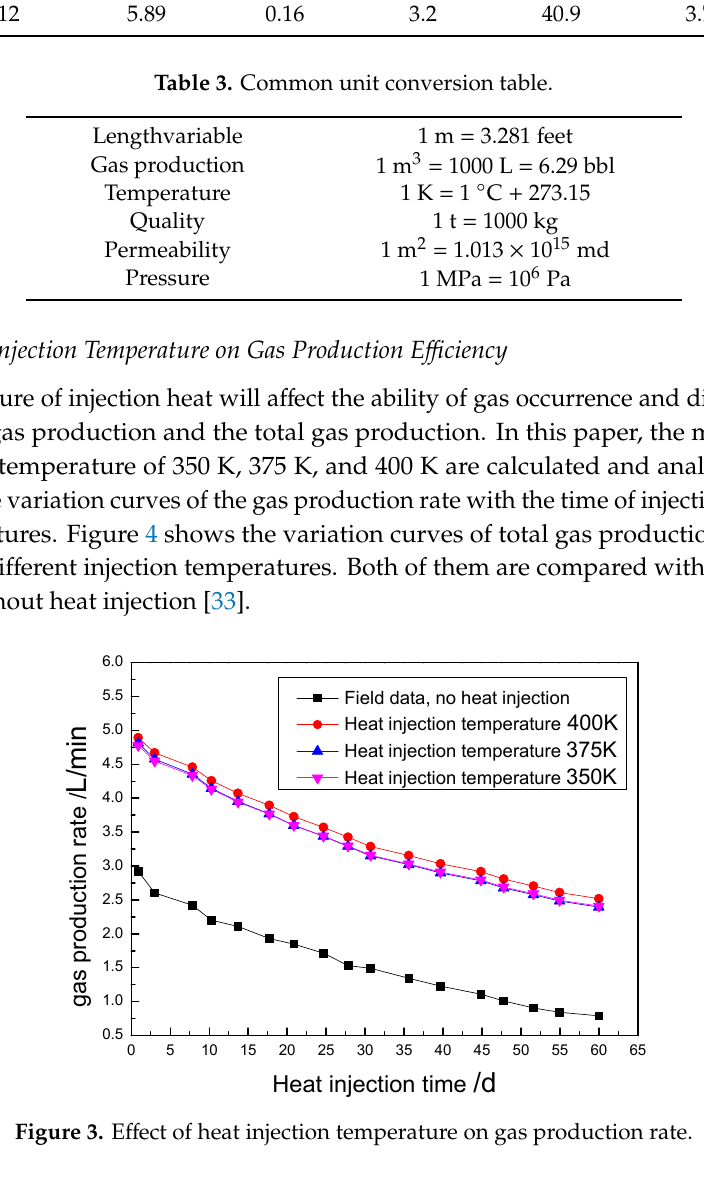
Heat injection temperature 350K Figure 4. Effect of heat injection temperature on total gas production. According to the Figure 3, when the injection temperatures are 400 K, 375 K, and 350 K, respectively, the gas production rates are 4.8944 L/min., 4.817 L/min., and 4.780 L/min at the initial stage of extraction. These data increased significantly compared with field data 2.920 L/min. with initial temperatures 300 K. The increase amplitudes are 67.62%, 64.95% and 63.69% respectively. When the mining period is 30 days, the gas production rates are 3.286 L/min., 3.159 L/min., and 3.150 L/min. of the injection temperatures 400 K, 375 K, and 350 K, respectively. The number increased more significantly when compared with field data 1.49 L/min. with the initial temperature 300 K. The increase amplitudes are 120.5%, 112%, and 111.4%, respectively. Therefore, we can see that the injection heat can obviously increase the gas production rate. In addition, the influence of injection heat on the increase of gas production is also significant with the development of mining. Figure 4 shows that the injection heat can effectively increase gas production, when the mining period is 30 days, the total gas production are 172,201.54 L, 167,158.66 L, and 166,792.9 L of the injection temperatures 400 K, 375 K, and 350 K, respectively. It increased more significantly when compared with field data 88,204.55 L with initial temperature 300 K, and the increase rate of coal-bed methane is 95.23%, 89.5%, and 89.09%, respectively. When the mining period is 60 days, the total gas productions are 293,939.57 L, 283,532.69 L, and 283,321.01 L of the injection temperatures 400 K, 375 K,